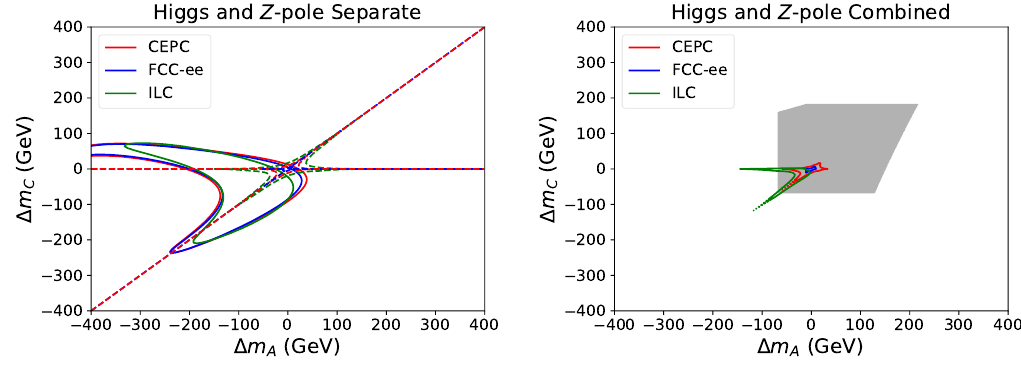
Figure 14 . Allowed region from two-parameter (cid:12)tting results at 95% C.L. in the (cid:1) m A plane with CEPC (red), Fcc-ee (blue) and ILC (green) precisions. The left and right panels are for Higgs/ Z -pole results individually and combined, respectively. Here m H = 800 GeV, p (cid:21)v 2 = (cid:11) ) = 0, tan (cid:12) = 1. In the left panel, Higgs precision measurement result is given 300 GeV, cos( (cid:12) (cid:0) by solid line while Z -pole precison measurement result is given by dashed line. The grey shadow in the right panel indicates the survival region of theoretical